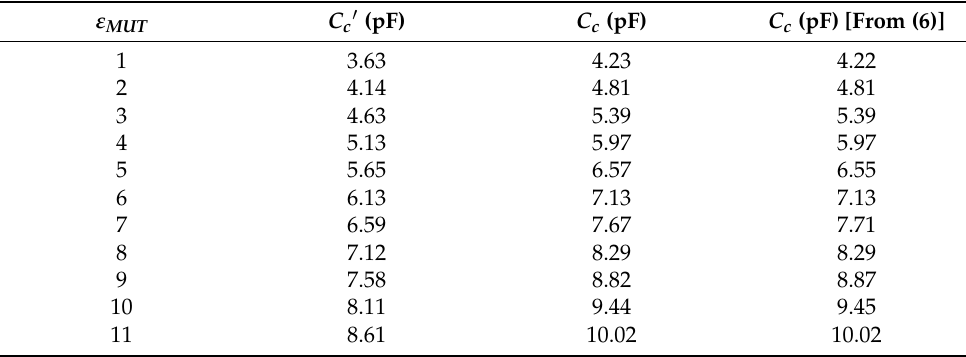
Table 2. Circuit parameters for different values of the dielectric constant of the